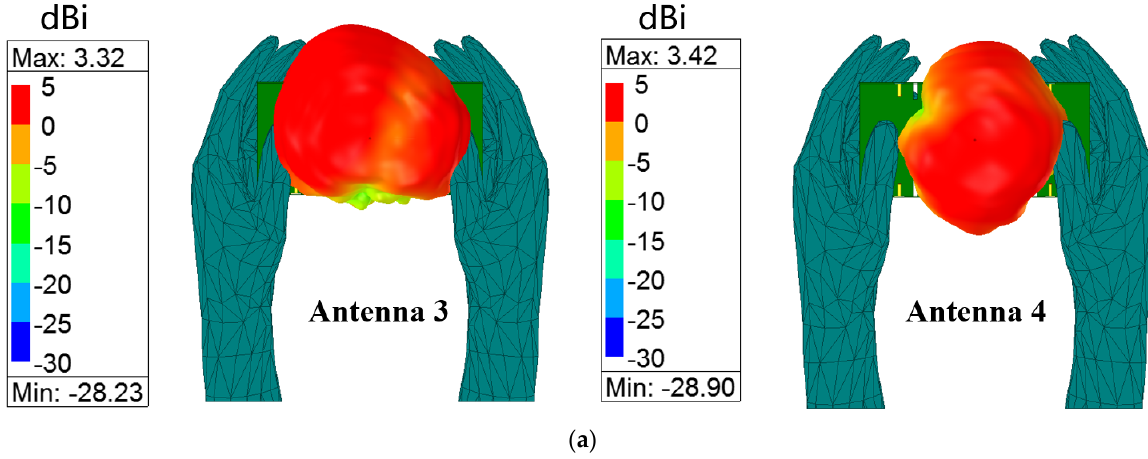
( b ) Figure 8. The simulated 3D radiation pictures of ( a ) Ant. 3 and Ant. 4 operate at 3.4 GHz; ( b ) Ant. 3 and Ant. 4 operate at 4.9 GHz.